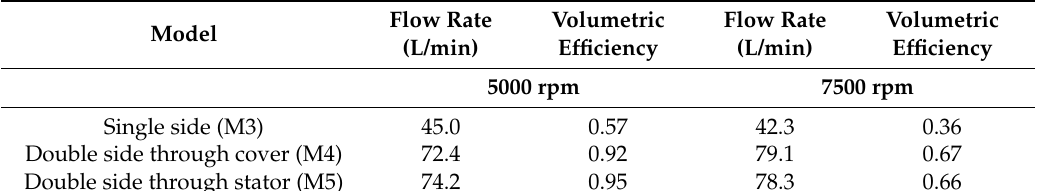
Table 5. Flow rate and volumetric efficiency at 5000 rpm and 7500 rpm, with three layouts of the suction ports, and a rotor with small diameter.